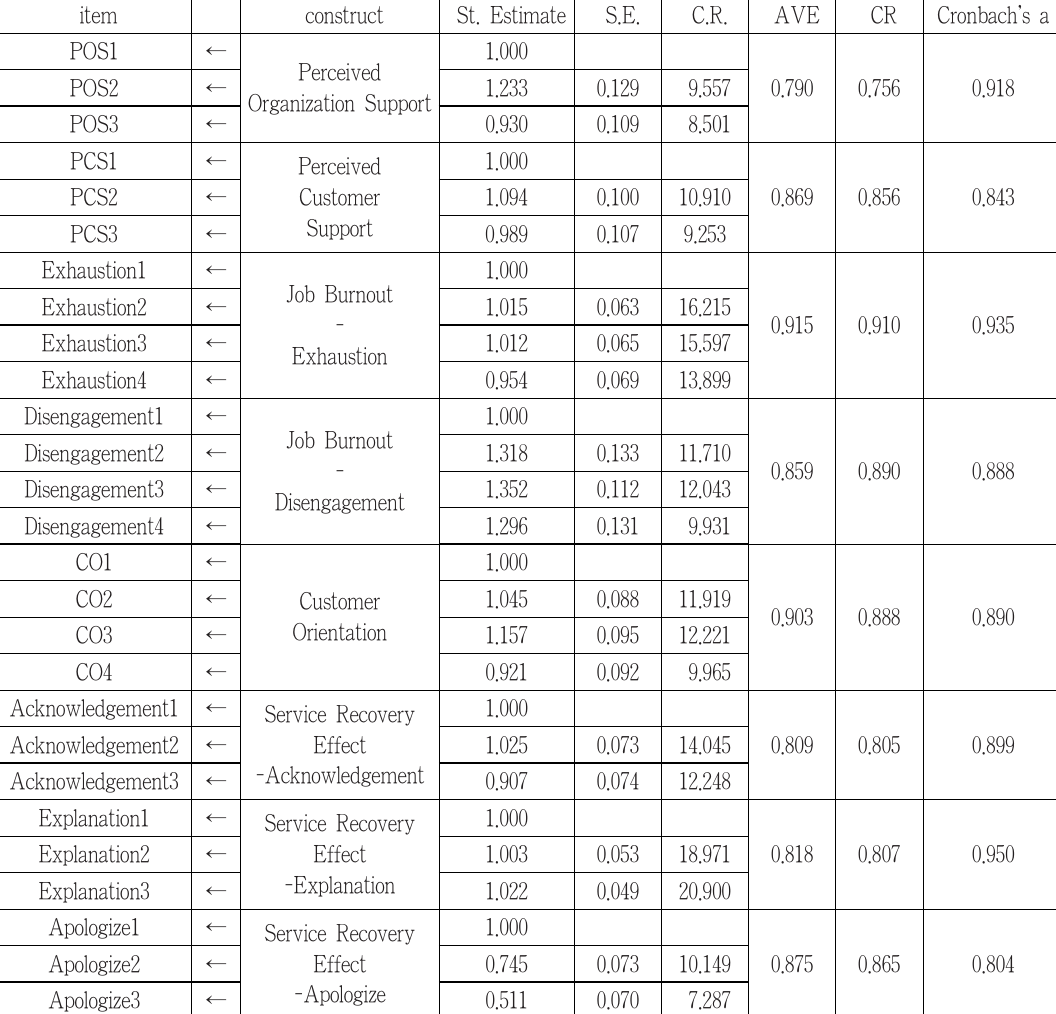
<Table 2> Reliability Test and Confirmatory Factor